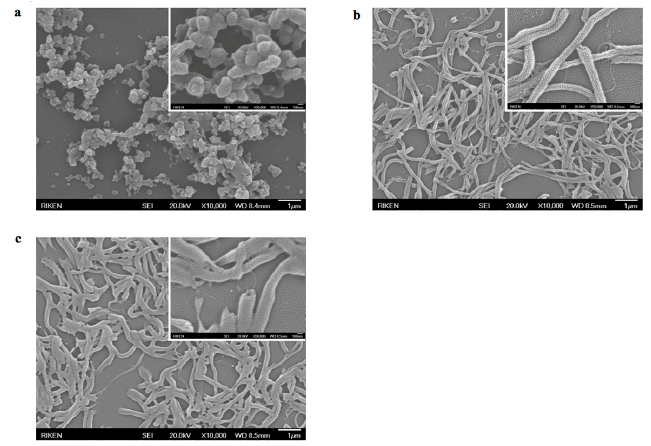
Figure 5. SEM images of nanotubes formed using ( a ) dopamine hydrochloride alone; ( b ) AC-dopamine 1:1; and ( c ) AC alone with the assistance of polycarbonate membranes. The insets in ( a – c ) are images with higher magnifications.